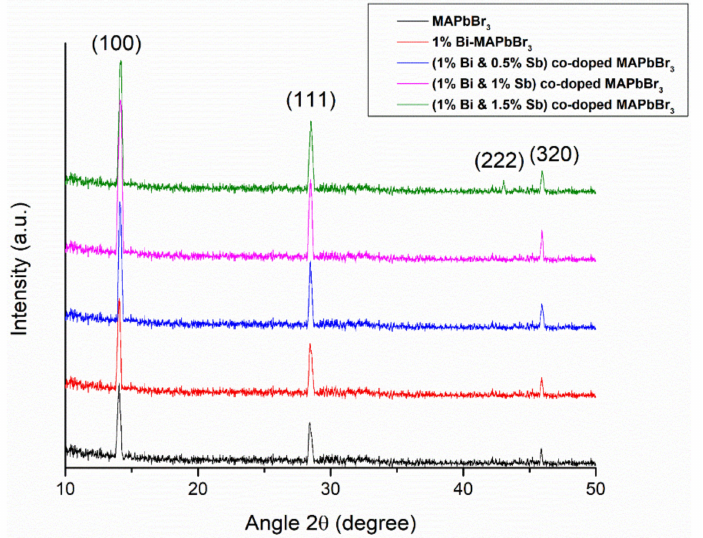
Figure 1. X-ray diffraction (XRD) of pure MAPbBr3 and co-doped (1%Bi & 0.5%, 1% and 1.5%